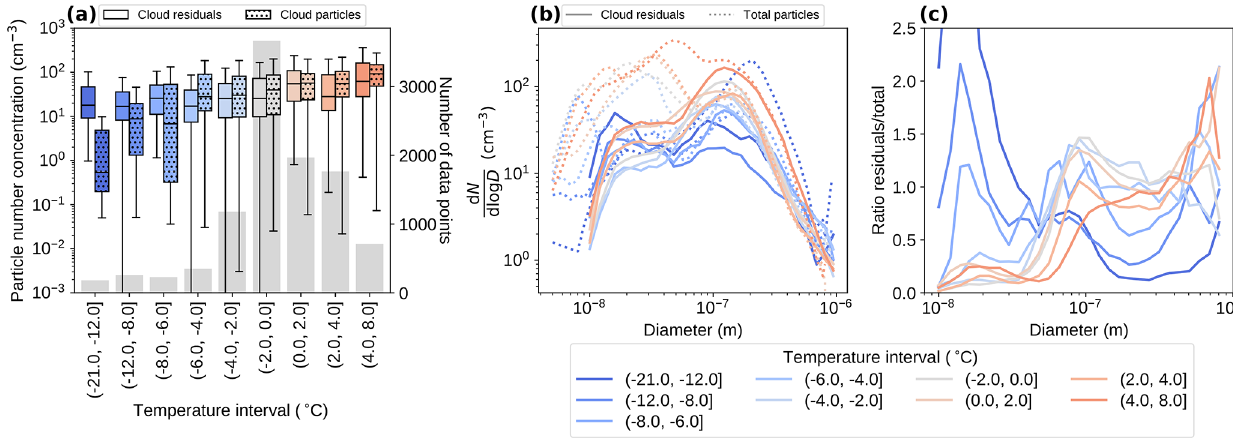
Figure 6. In-cloud data binned by temperature. (a) Box plot of cloud residual (solid) and cloud particle (hatched) number concentrations for different temperature intervals (see legend). The whiskers extend to the farthest points that are within 1.5 times the interquartile range from the nearest quartile. Points that fall outside the whiskers are not shown. The grey bars in the background indicate the number of cloud residual data points (right y axis) per temperature bin. (b) Mean particle number size distributions of cloud residuals (solid) and total particles (dotted) for different temperature intervals (see legend). (c) Ratio of the size distributions in (b) , i.e. cloud residual concentrations divided by total particle concentrations.